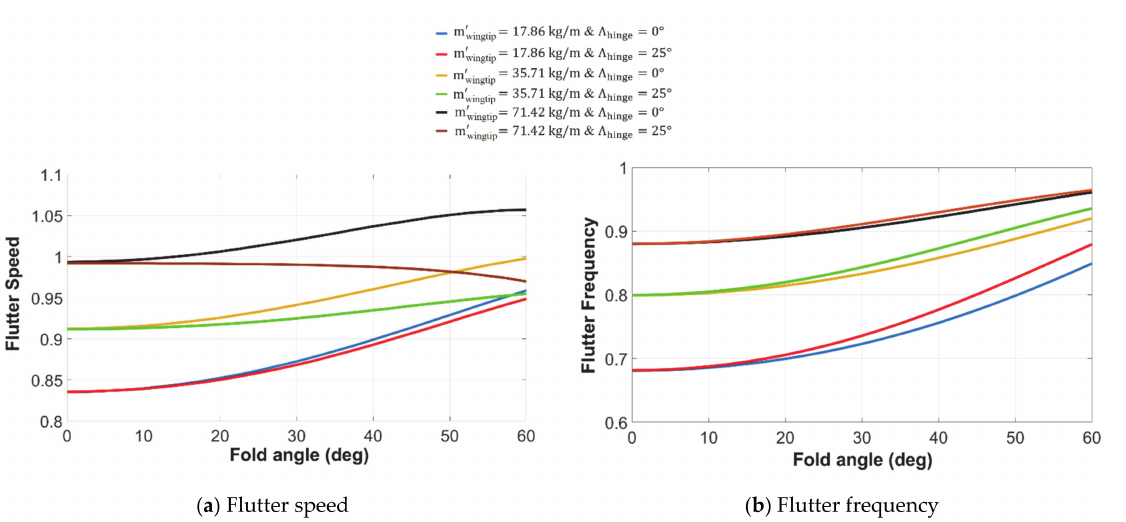
Figure 13. Effect of wingtip mass on aeroelasticity.